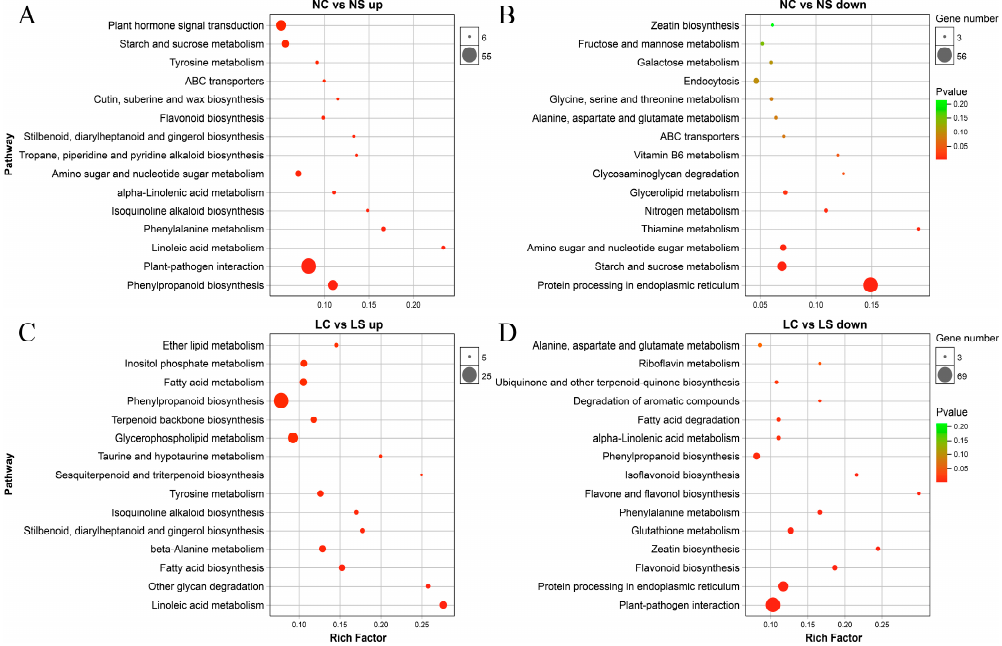
Figure 4. Kyoto Encyclopedia of Genes and Genomes (KEGG) Pathway enrichment analysis of DEGs identified. KEGG Pathway analysis based on ( A ) the di ff erentially upregulated genes and ( B ) downregulated genes between NC vs NS. KEGG Pathway analysis based on ( C ) the di ff erentially upregulated genes and ( D ) downregulated genes between LC vs LS. NS and NC refer to SMV infection and control, respectively, under normal light, while LS and LC refer to SMV infection and control, respectively, in the